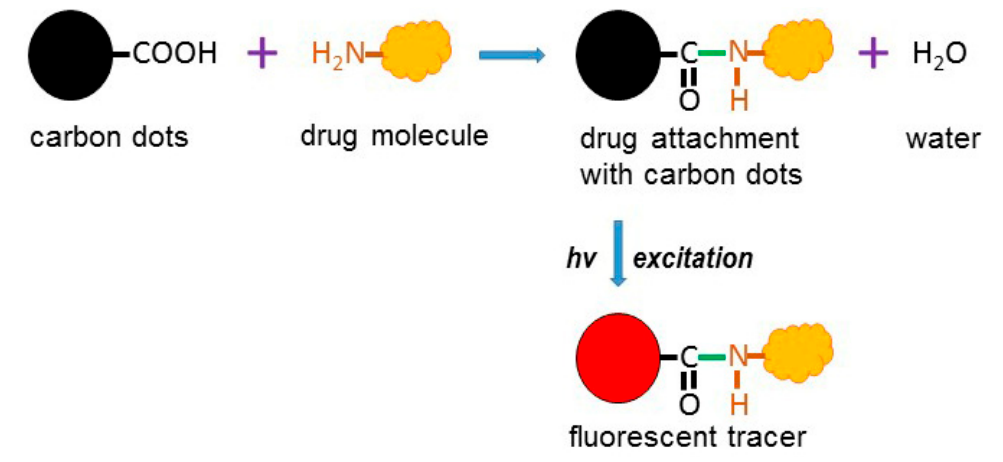
Figure 2. Carbon nanodot-based drug delivery and tracking. Schematic representation showing conjugation of carbon nanodots with drug molecules, and subsequent excitation to generate agents that act simultaneously as fluorescence tracers and drug delivery vehicles.